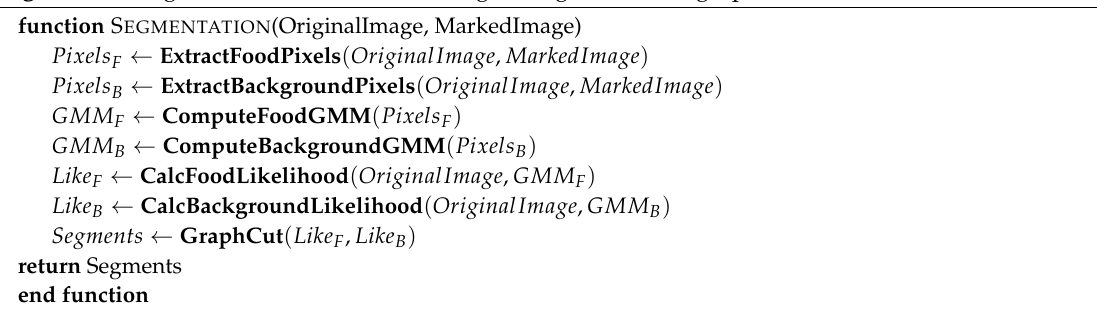
Algorithm 2 Segmentation of a marked image using GMM and graph-cut